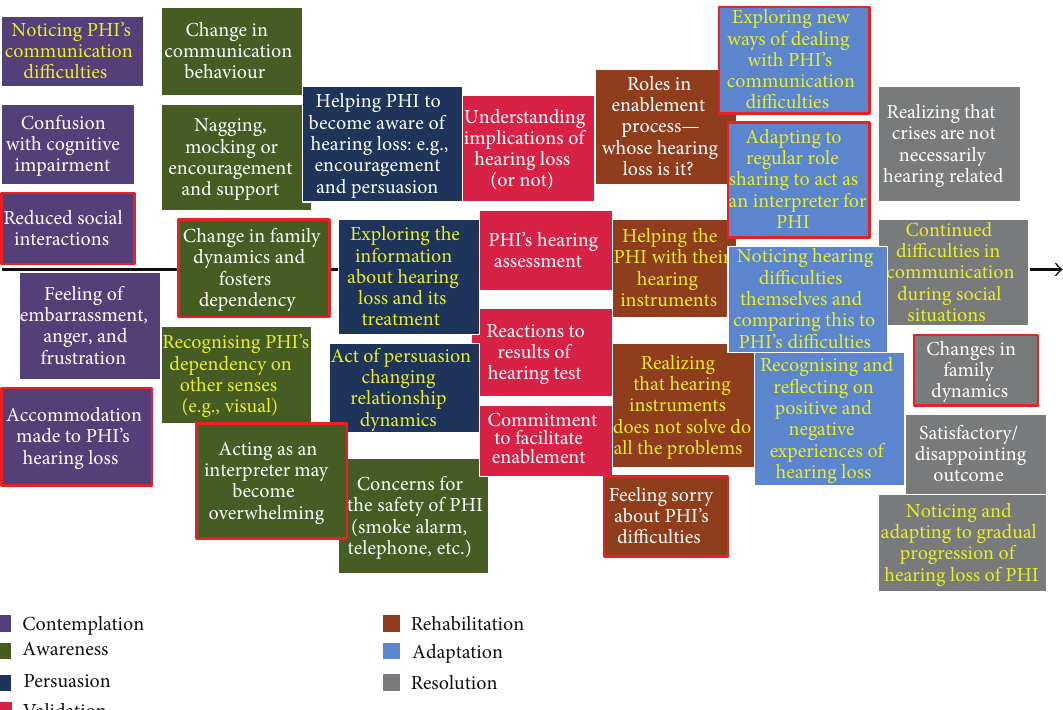
Figure 2: Communication partner’s perspectives of their journey through their partners’ hearing impairment (stages identified only by CPs are highlighted in yellow text, and stages which are reported in multiple phases are highlighted with red